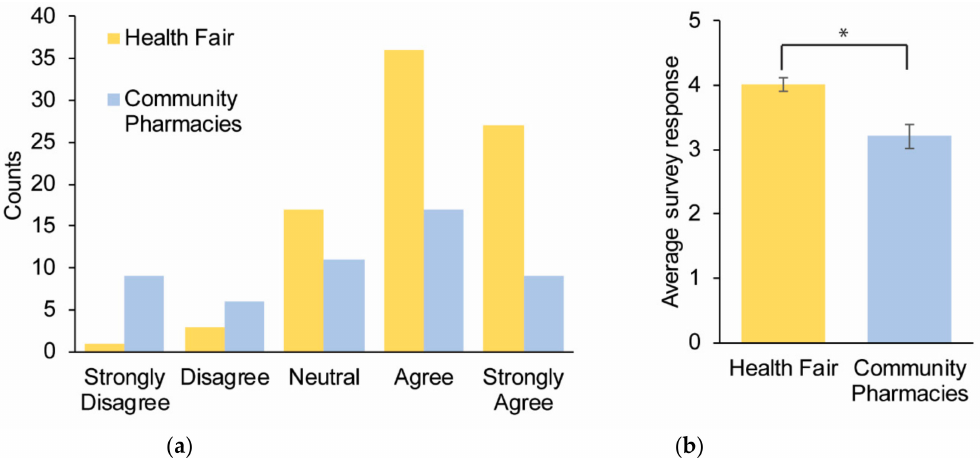
Figure 1. Survey responses to the question: “I understand what pharmacogenomics is”. A total of 137 participants provided responses across multiple sites and were subsequently categorized as the symposium ( n = 85) and community pharmacy ( n = 52) participants. ( a ) Cumulative responses for each category depicted by di ff erent colors for the two cohorts. ( b ) The average survey response for the two cohorts. Error bars =